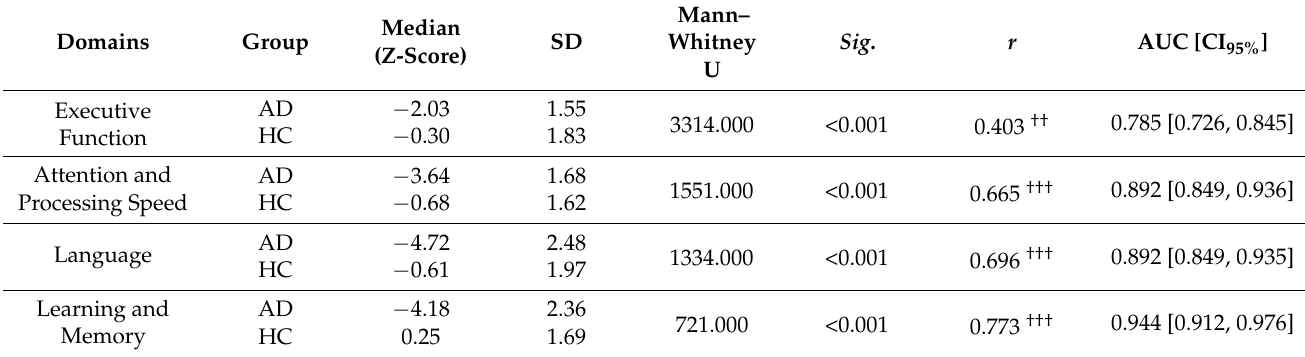
Table 5. Average performance between groups by cognitive domain.